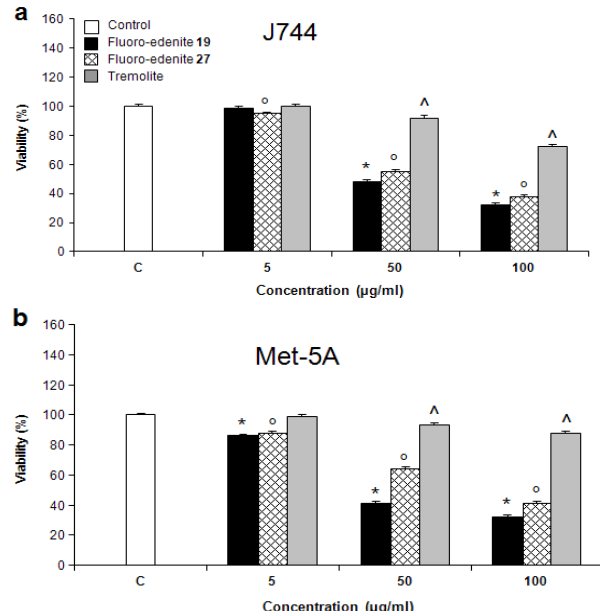
Figure 5: Viability of J774 (a) and Met-5A (b) cells measured with the MTT assay following exposure to mineral fibers. The values of optical density measured at 550 nm are reported as percentage with respect to the optical density registered for untreated control, the latter considered as 100 % of cell viability. The values are the mean ± SEM of three